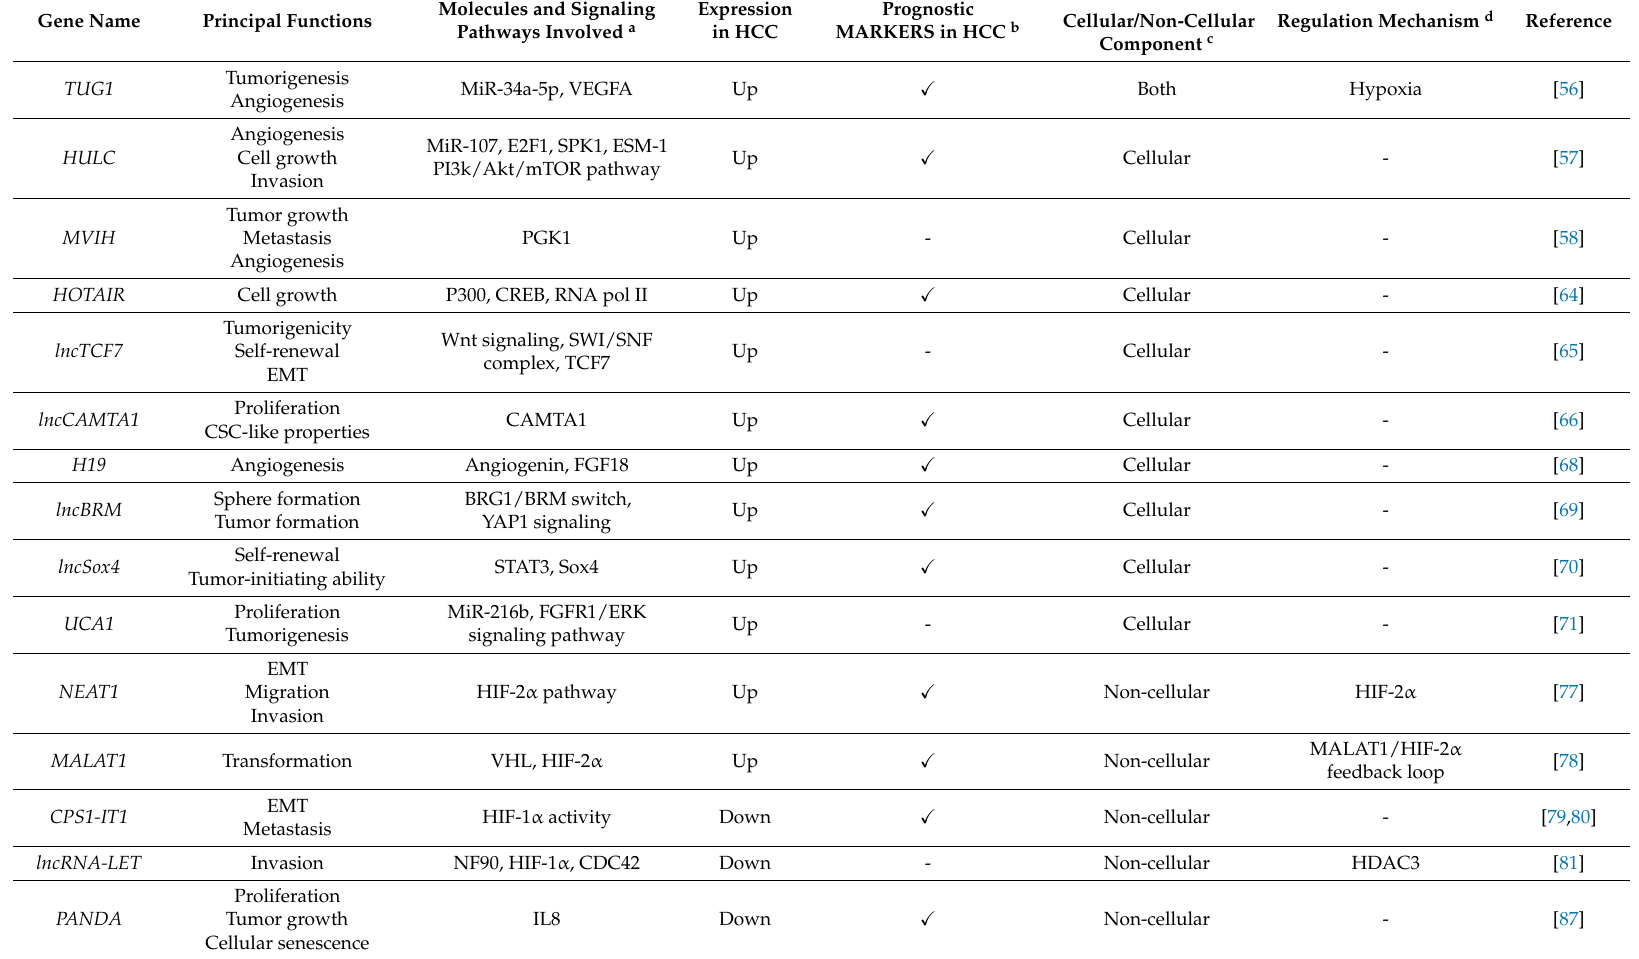
Table 1. Tumor microenvironment-related lncRNAs and their potential mechanisms in hepatocellular carcinoma